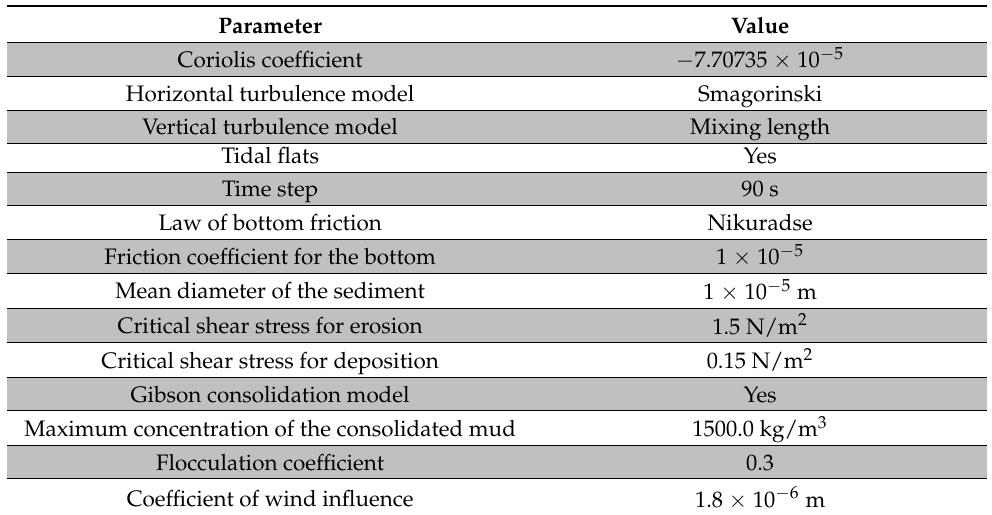
Table 1. The best set of physical parameters resulting from the calibration exercise of the TELEMAC- 3D